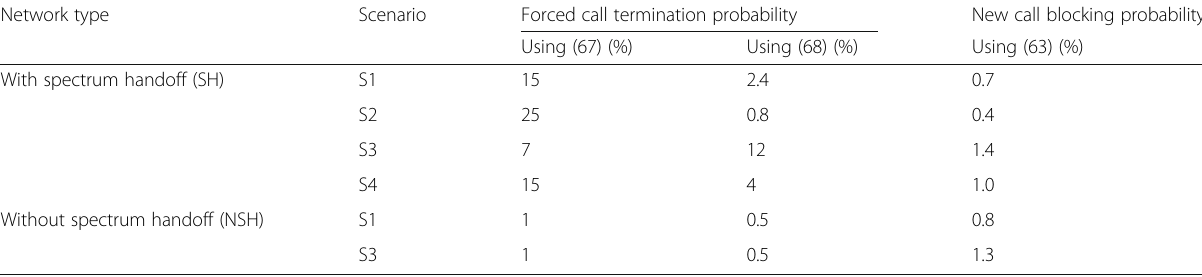
Table 7 Maximum relative difference between analytical and simulation numerical results for both forced call termination and new call blocking